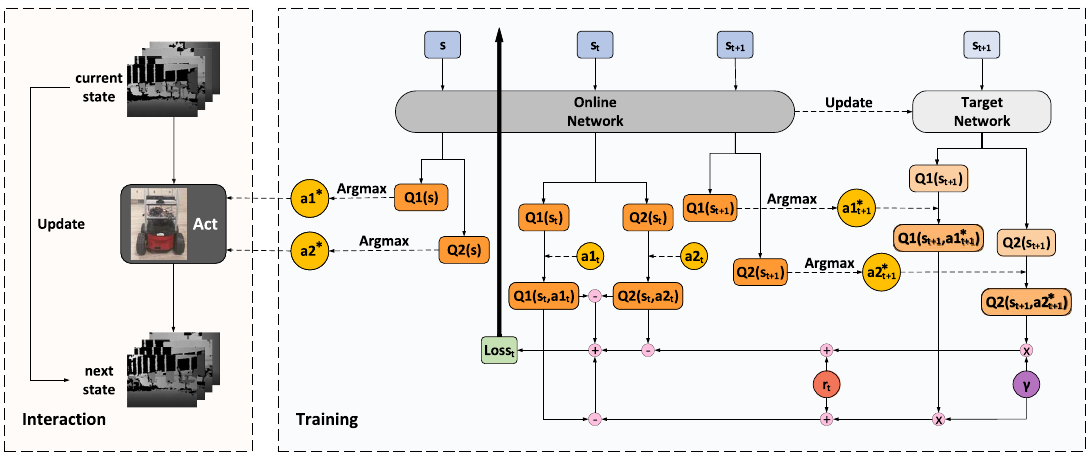
Figure 2. Training framework of the BND-DDQN model. The online network is used to output control commands and evaluate the policies while the target network is employed to estimate the target values for evaluation. At each iteration, the current state is fed through the online network to compute the Q-values of the executed actions whereas the next state is passed into both networks to determine the corresponding target Q-values together with the discounted factor and the immediate reward. The loss function is calculated as a combination of three terms, including the difference between the first Q-value and its target value, the difference between the second Q-value and its target value, and the difference between the two Q-values. The loss is back-propagated through the online network to update its parameters while the target network is a periodic duplicate of the online